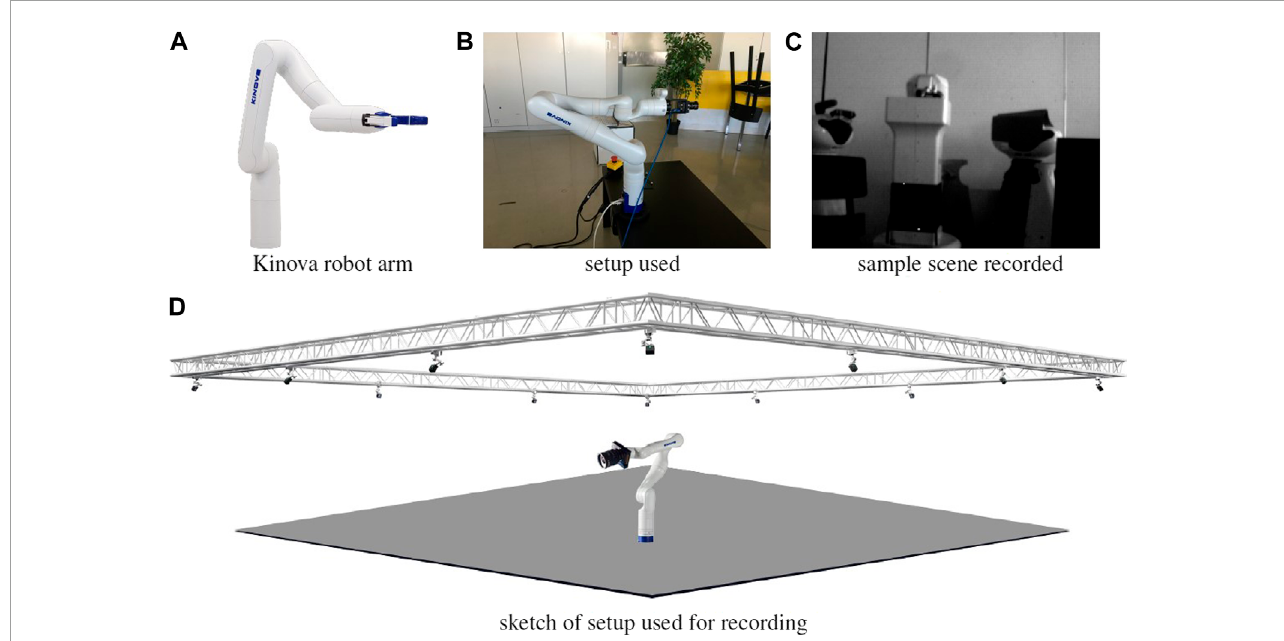
FIGURE 7 Setup for dataset recording in (B,C) , showing the Kinova robot arm (A) for trajectory generation and groundtruth recording, and surrounding motion capture system (D) for groundtruth recording. The DVS240 camera is coupled at the end of the arm, shown in (B,D) .